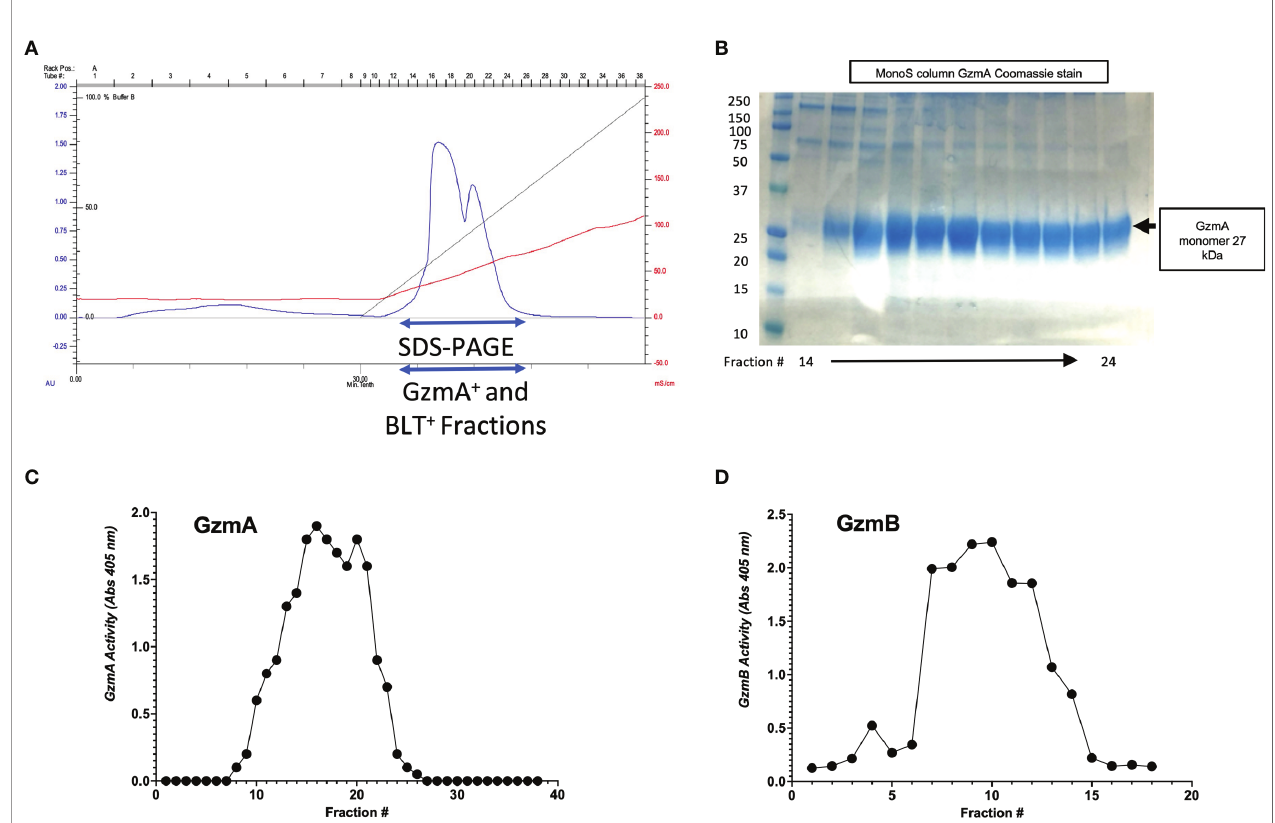
FIGURE 3 | MonoS puri fi cation of Gzms. (A) Representative chromatogram of MonoS run for GzmA (similar layout for GzmB) showing elution of GzmA around 650 mM NaCl (e.g., fractions 12 through 27). (B) Fractions 14 through 24 were probed by SDS-PAGE under reducing conditions followed by Coomassie staining, which show GzmA monomer at 27 kDa. On the left, MW markers. (C) Substrate activity assay for GzmA (BLT assay) using the MonoS fractions, where substrate is in excess compared to protein. (D) Substrate activity assay for GzmB (AAD) using MonoS